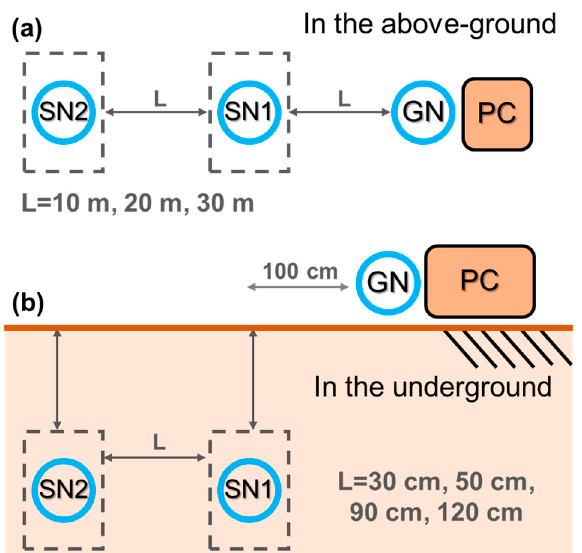
Figure 4. Peer-to-peer transmission test sensor configuration diagram for ( a ) ground transmission and ( b ) underground transmission.